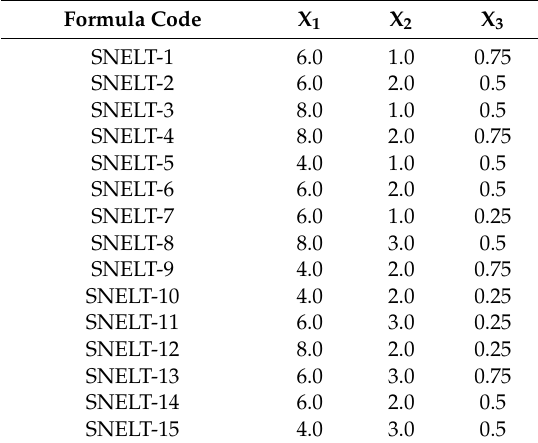
Table 3. Independent factor percentages in the formulations of FBX-SNELTs in a randomized order as suggested by a Box–Behnken design.